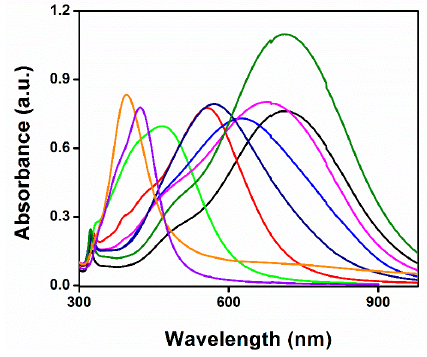
Figure 6. UV-vis spectra of Ag-NPrs formation with an average time interval of 21.75 s.